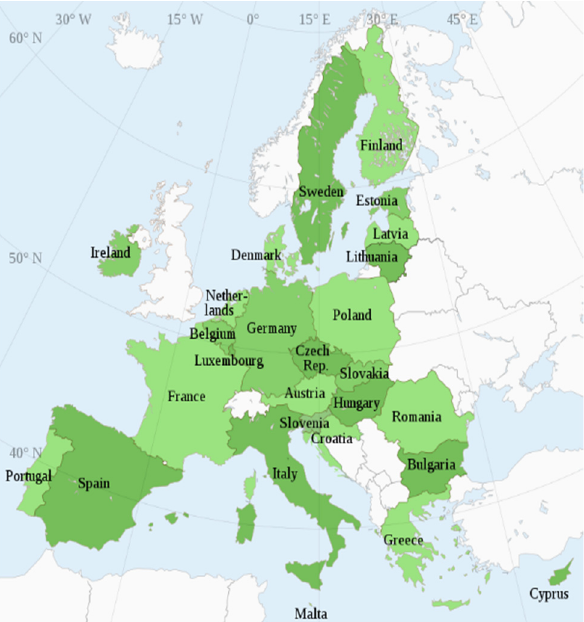
Figure 1. EU member states. Picture from https://commons.wikimedia.org/ under the Creative Commons Attribution-Share Alike 4.0 International license. The color difference is only to distinguish one country from the confining ones.